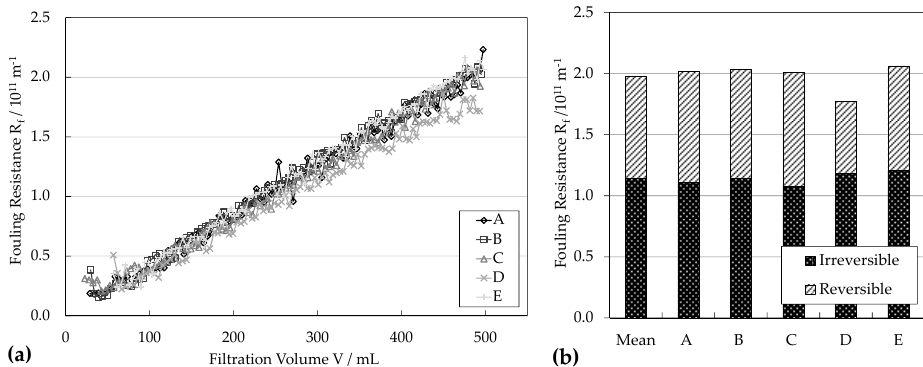
Figure 2. Reference fouling experiments: Ultrafiltration without pre-adsorption (five repetitions) ( a ) Fouling resistance development during filtration of 500 mL raw water; ( b ) Hydraulic reversible and irreversible resistance after filtration of 500 mL raw water. (Membrane: 150 kDa; PES; 2.87 × 10 − 3 m 2 ) With respect to the hydraulic reversibility, almost 60% of the fouling cannot be removed by hydraulic backwash. Average hydraulic irreversible resistance accounted for 1.15 ± 0.11 × 10 11 m − 1